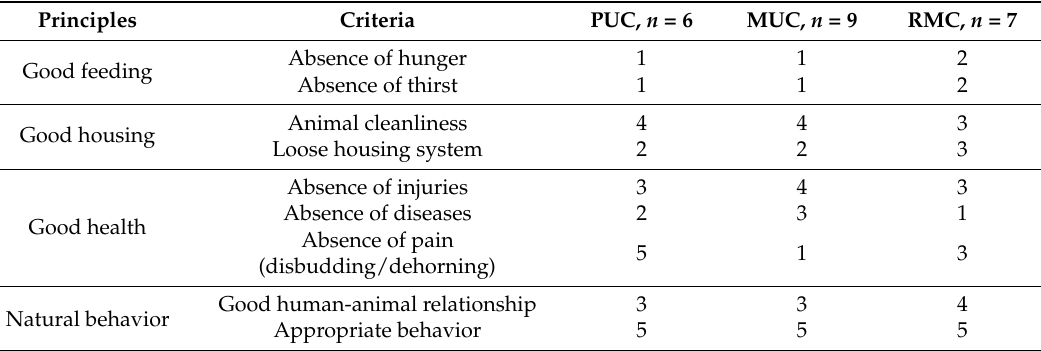
Table 2. Preferences (1 = most important, 5 = least important) on dairy cattle welfare attributes as expressed by plain urban consumers (PUC), mountain urban consumers (MUC), and rural mountain consumers